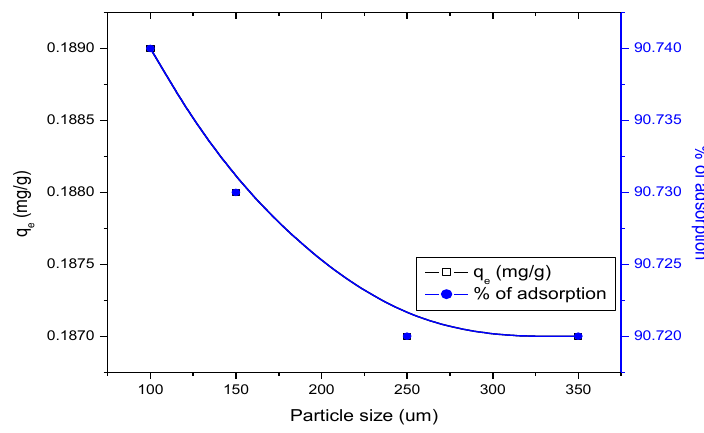
Figure 6a. Effect of particle size on the adsorption of fluoride by eggshell powder (experimental conditions: Initial fluoride concentration: 5.0 mg/L, pH: 6.0, adsorbent dose: 2.4 g/100ml, agitation speed: 250 rpm, Contact time: 60 minutes, Temperature: 303 K).